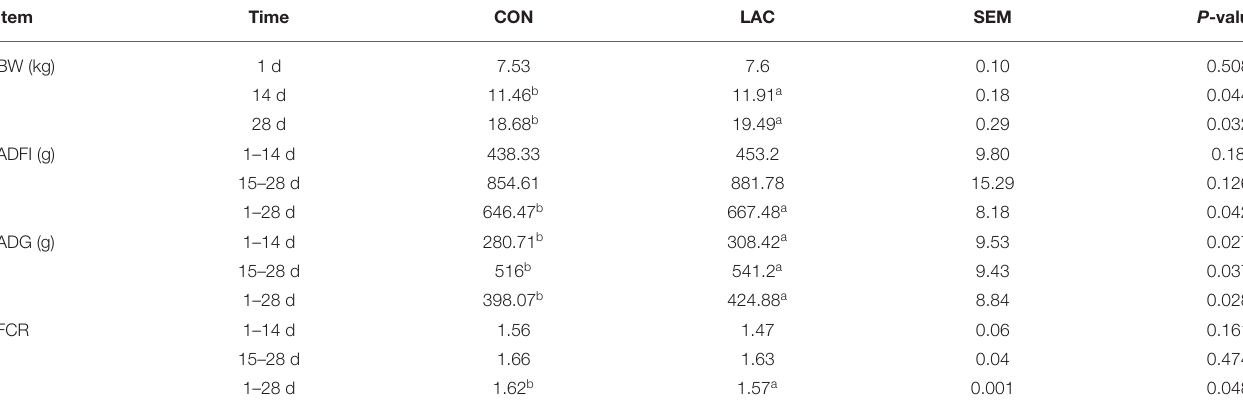
TABLE 2 | Effects of Lactobacillus delbrueckii on growth performance in weaned piglets. Item